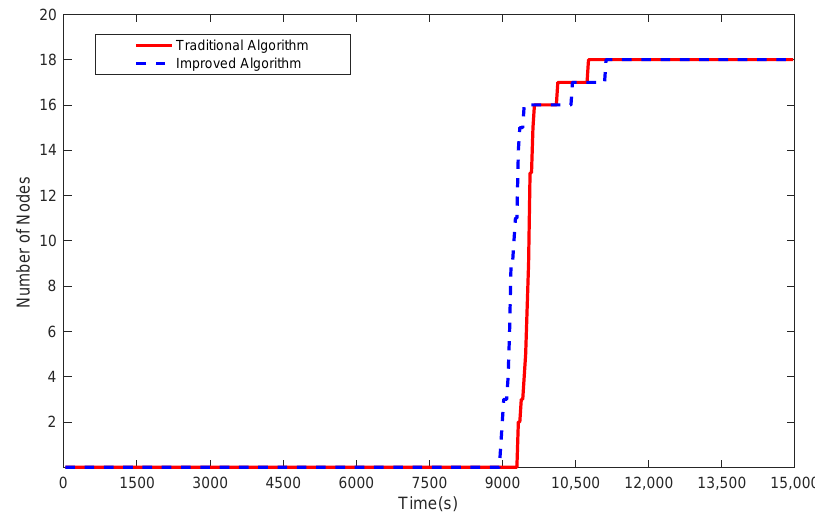
Figure 9. The time-varying number of key nodes with residual energy less than τ in the two